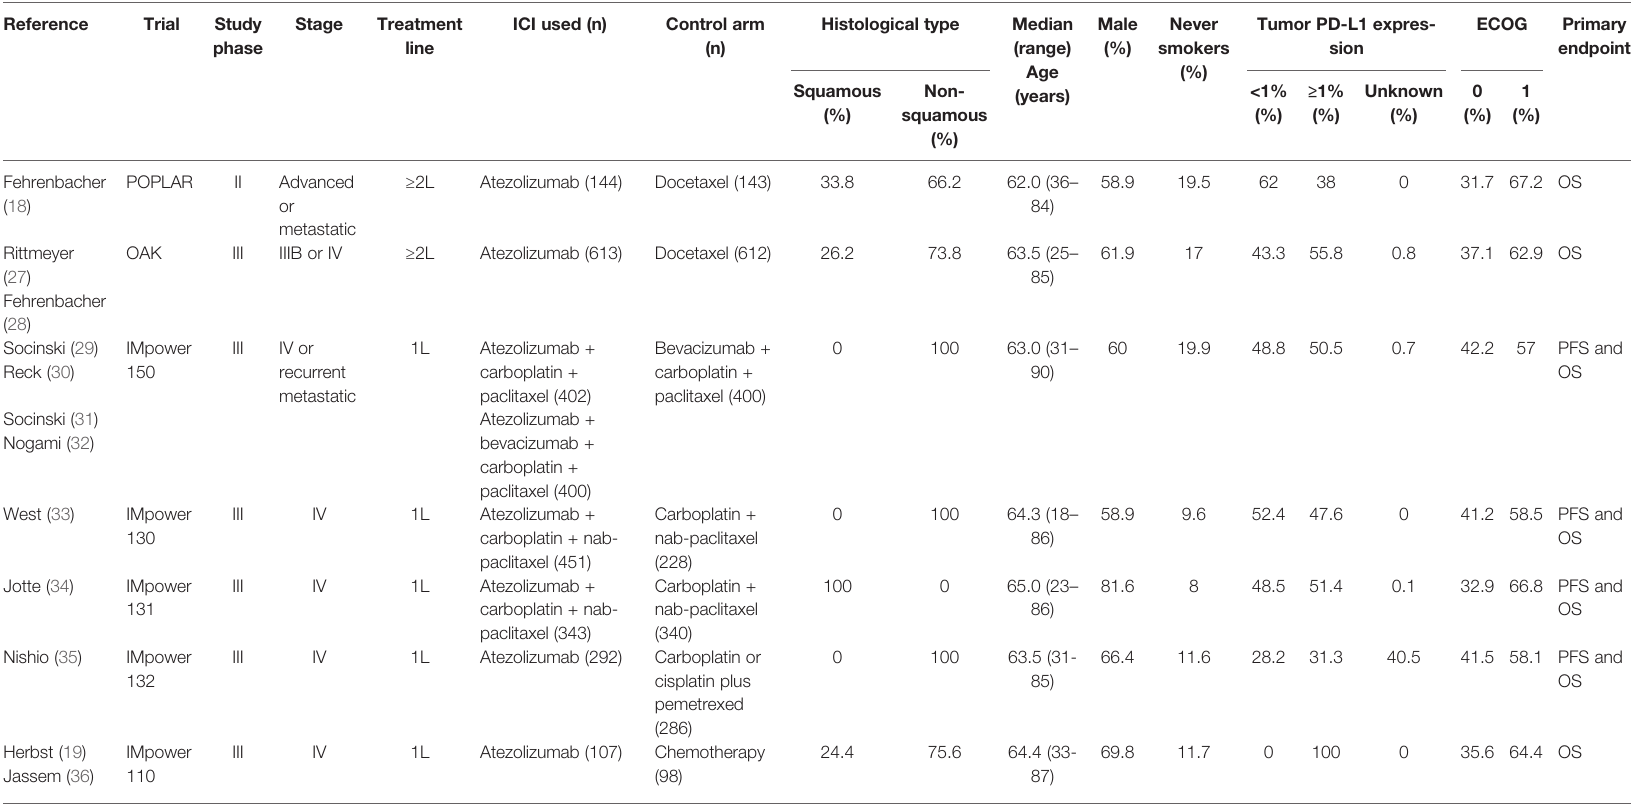
TABLE 1 | Basic characteristics of included